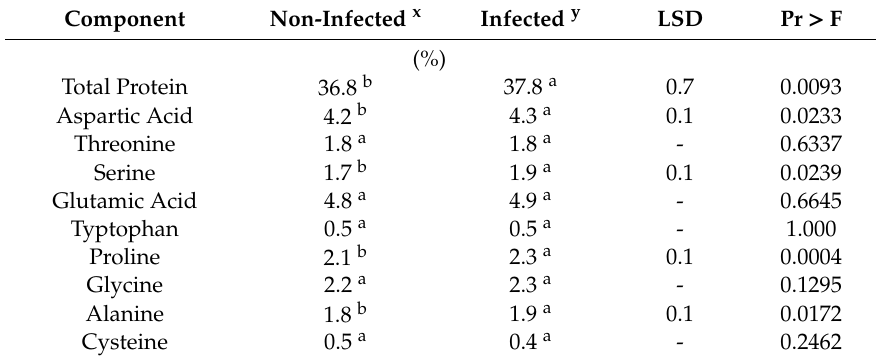
Table 3. The comparison of non-infected (non-symptomatic) compared to infected soybean seed for seed total protein and amino acids content. The field experiment was conducted in 2019 at the Delta Research and Extension Center in Stoneville,